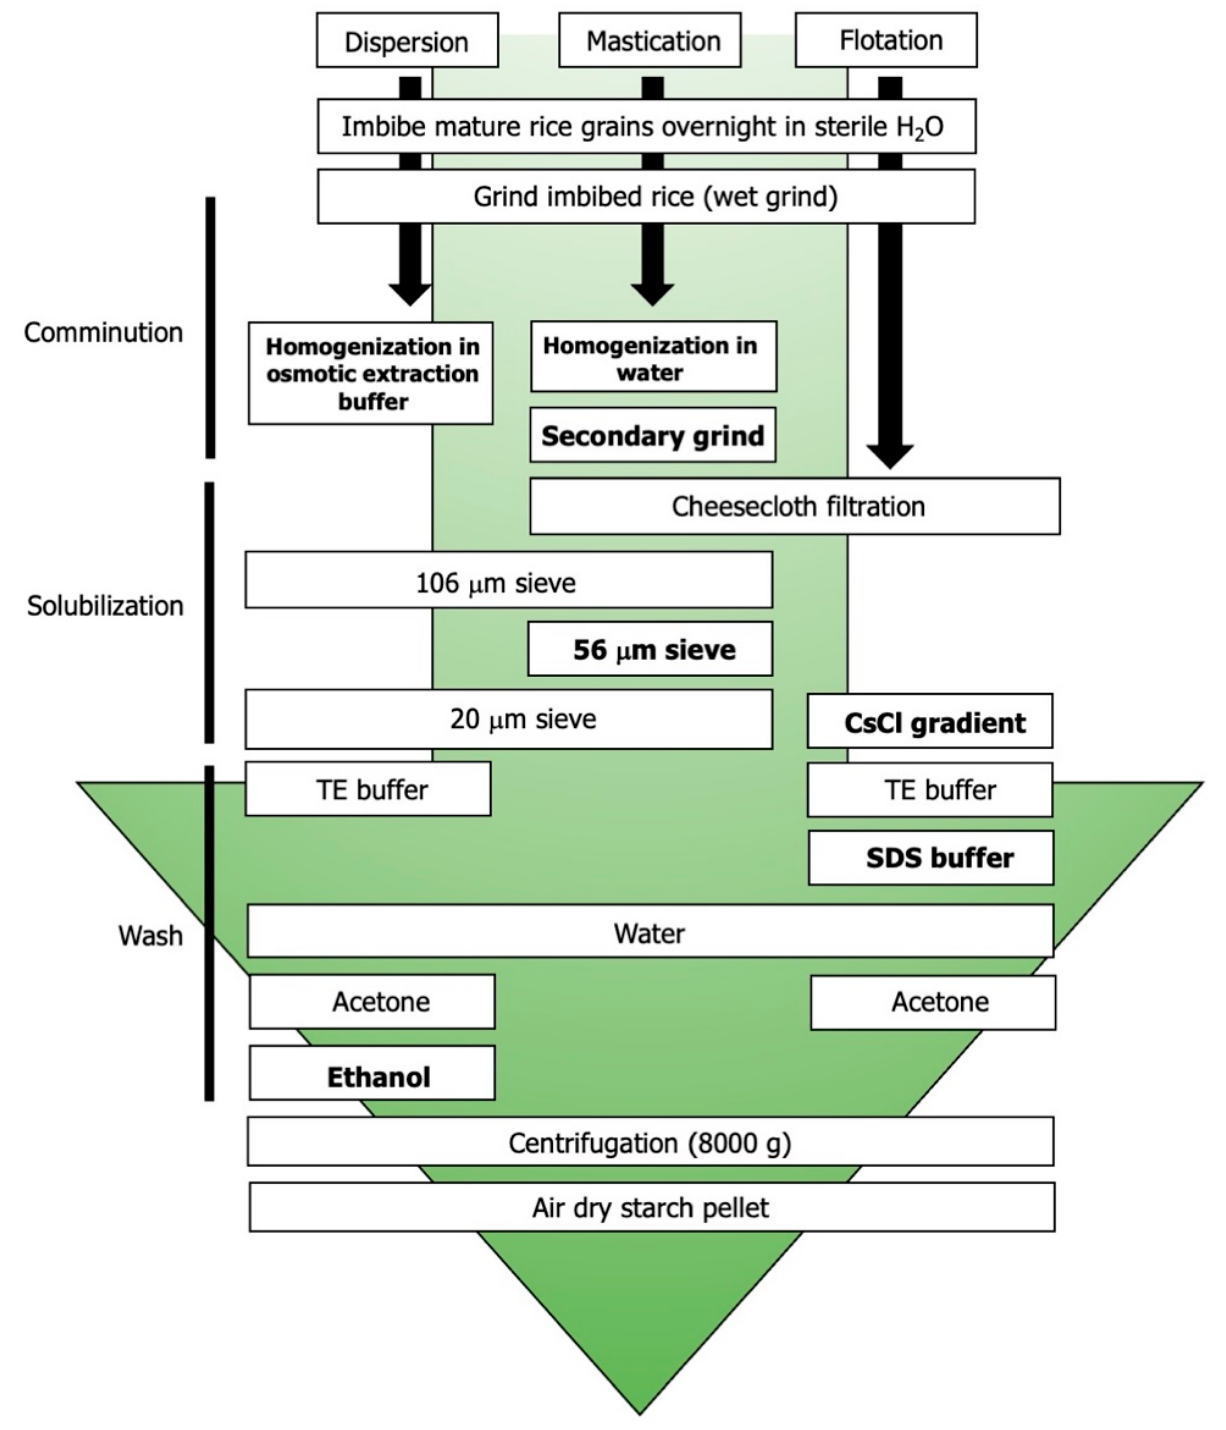
Figure 1. The various preparation methods used to compare starch granules in this study. Biochemical isolation steps that were unique to the preparation method are represented in boldface font.